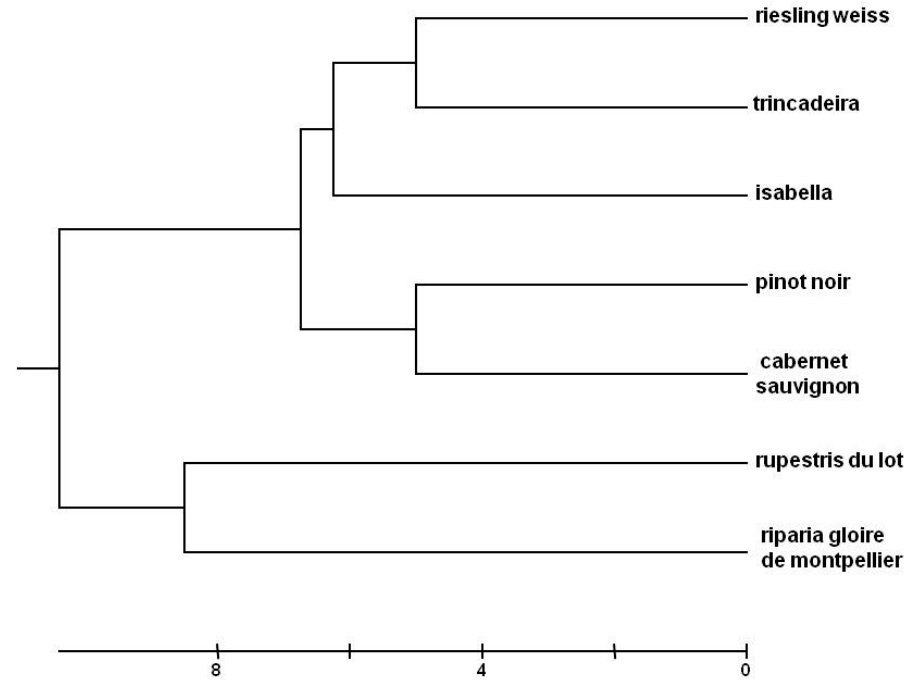
Figure 1. Phenogram of the genotyped Vitis samples based on the unweighted pair group method with arithmetic mean averages with a squared distances matrix, generated with allelic data from the nine SSR polymorphisms analyzed.